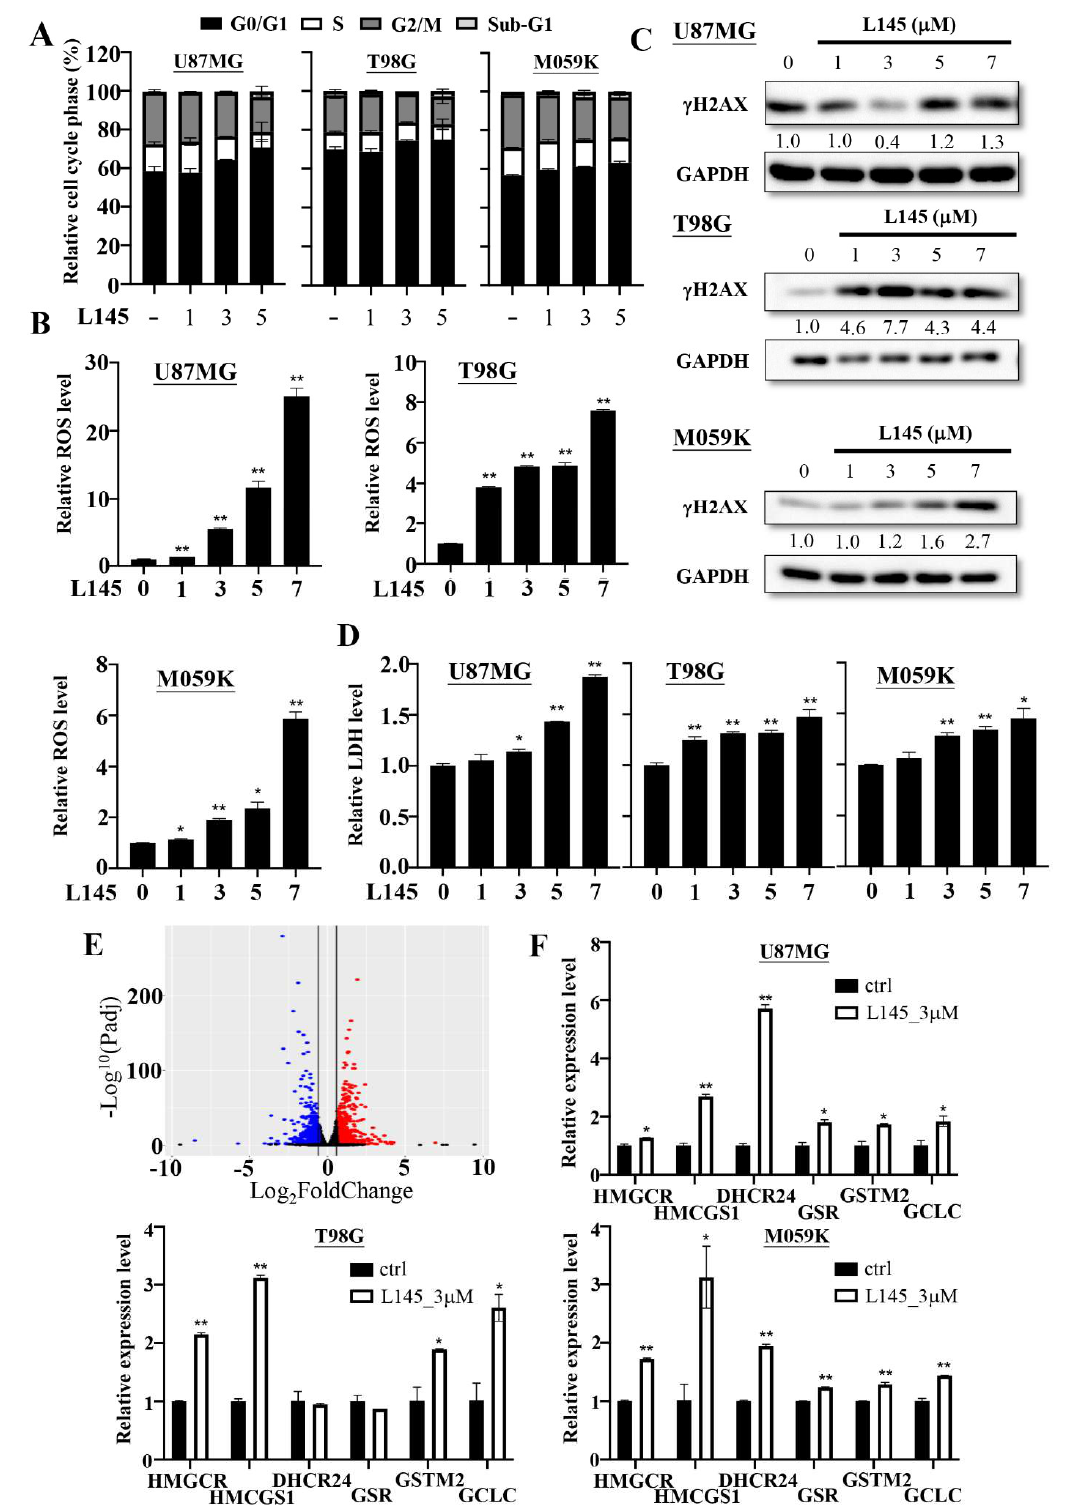
Figure 4. Effects of MPT0L145 on the U87MG, T98G and M059K cells. ( A ) The three cancer cells were exposed to the indicated concentrations ( µ M) of MPT0L145 for 24 h and then subjected to cell cycle analysis. Data are presented as the mean ± SD (n = 2). ( B ) The three cancer cells were treated with the indicated concentrations ( µ M) of MPT0L145 for 72 h. Accumulation of intracellular ROS levels were measured by luminometer. The luminescence units were normalized by the absorption value (O.D. 570 nm) from the MTT assay representing cell amounts, and fold changes were calculated and